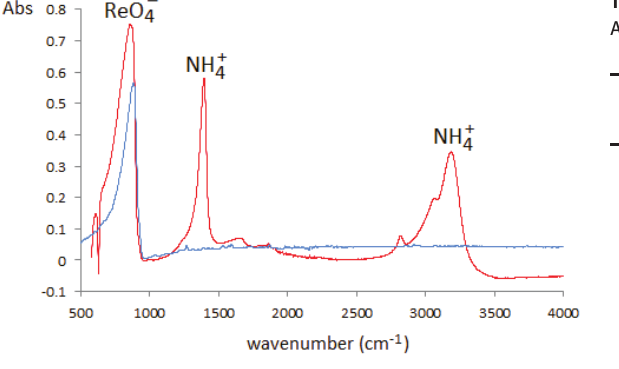
Figure 4: Ammonium perrhenate IR spectrum compared to potassium perrhenate spectra.